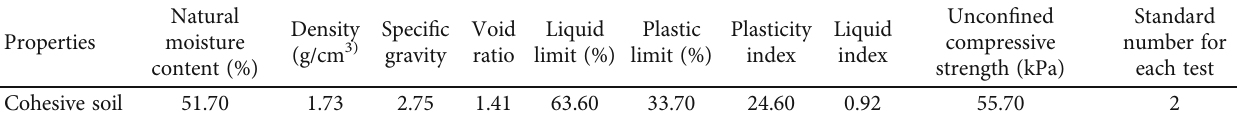
Figure 1: Location of the tested cohesive soil. Table 1: Basic index properties of the tested cohesive